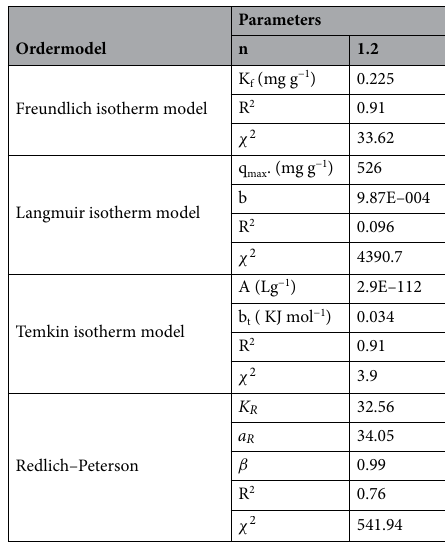
Table 9. Freundlich, Langmuir and Temkin parameters for the sorption of Cu (II) ions on GFLE.